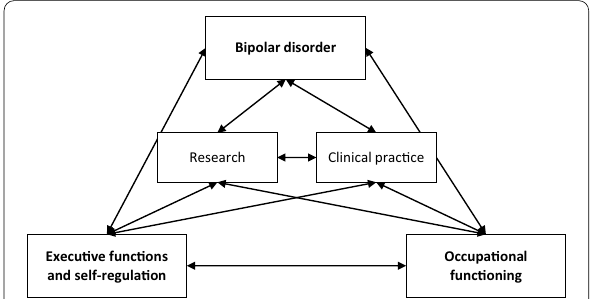
Fig. 3. Relationships between BD, OF and